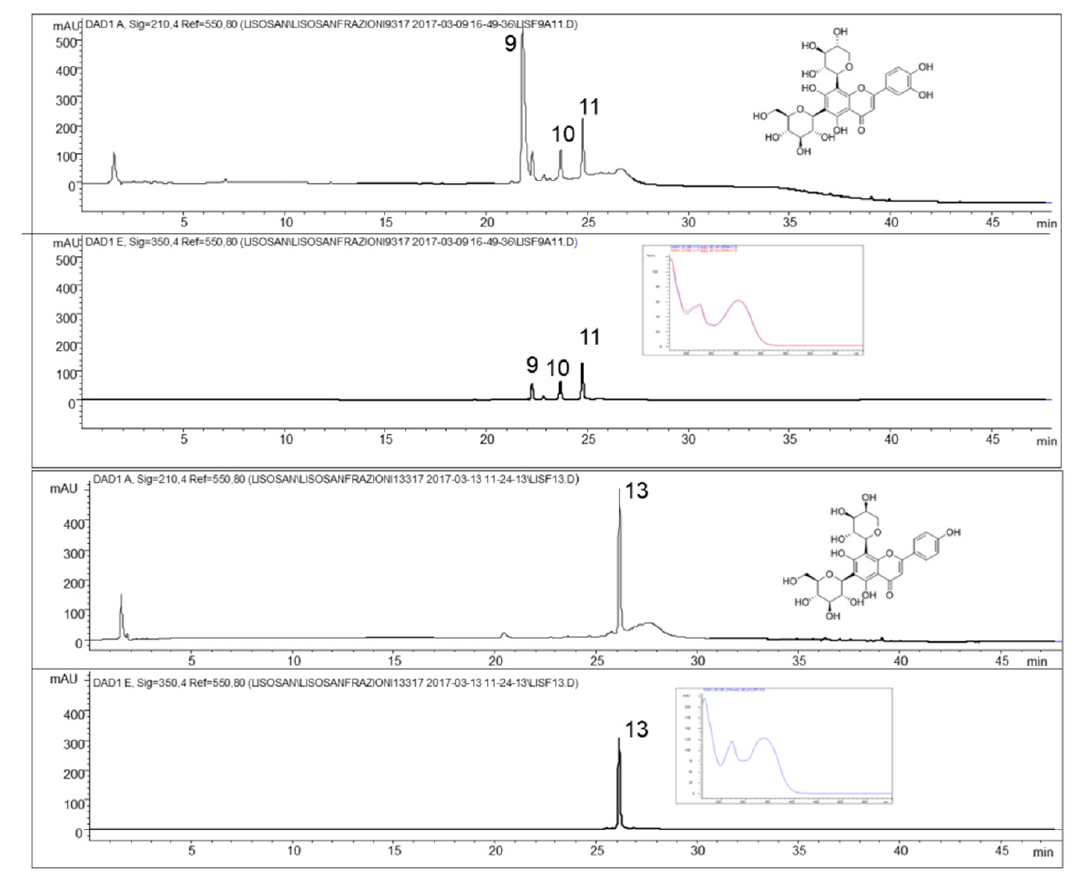
Figure 2. Chromatographic profiles at 210 nm and 350 nm of the two fractions containing the C -glycosylated flavonoids recovered by semi-preparative HPLC; 9 and 10 , neocarlinoside/isocarlinoside/carlinoside; 11 , isoschaftoside; 13 , schaftoside (UV–VIS spectra of peaks 9 and 13 and chemical formula of carlinoside and schaftoside are also shown).